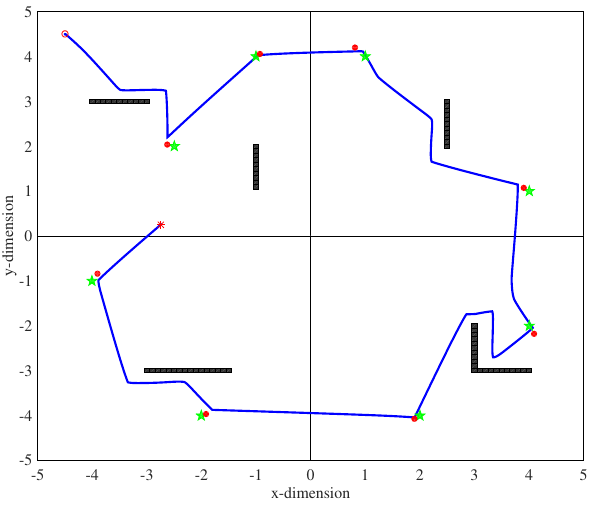
Figure 4. The robot’s movement path for Case